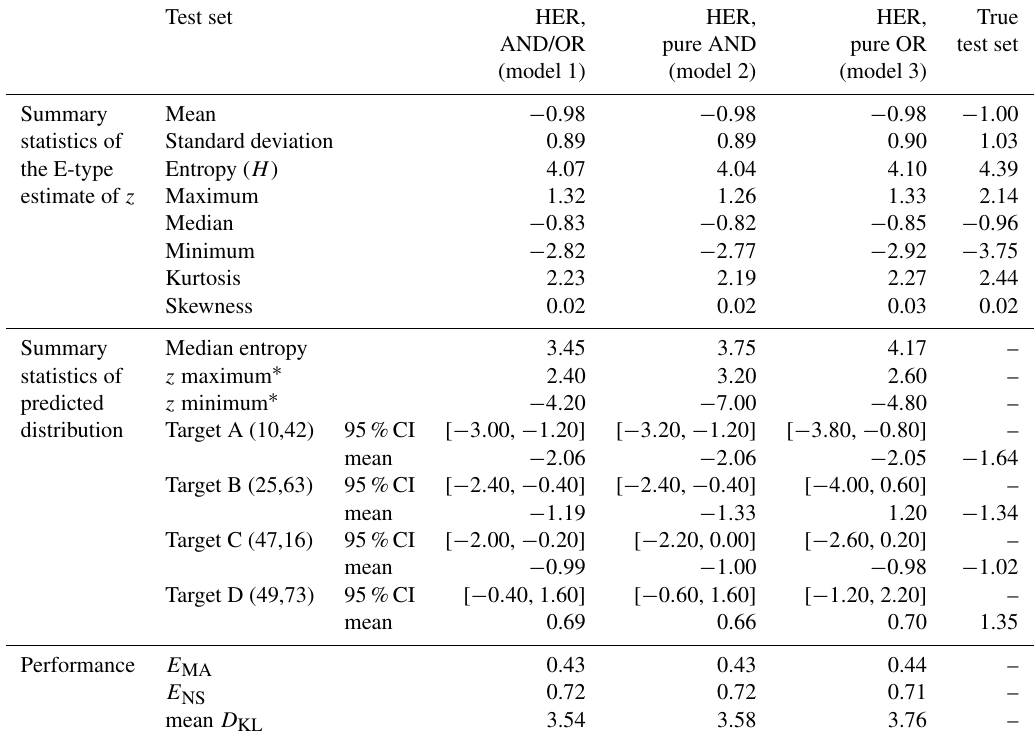
Table 1. Summary statistics and model performance of LR1-600. Test